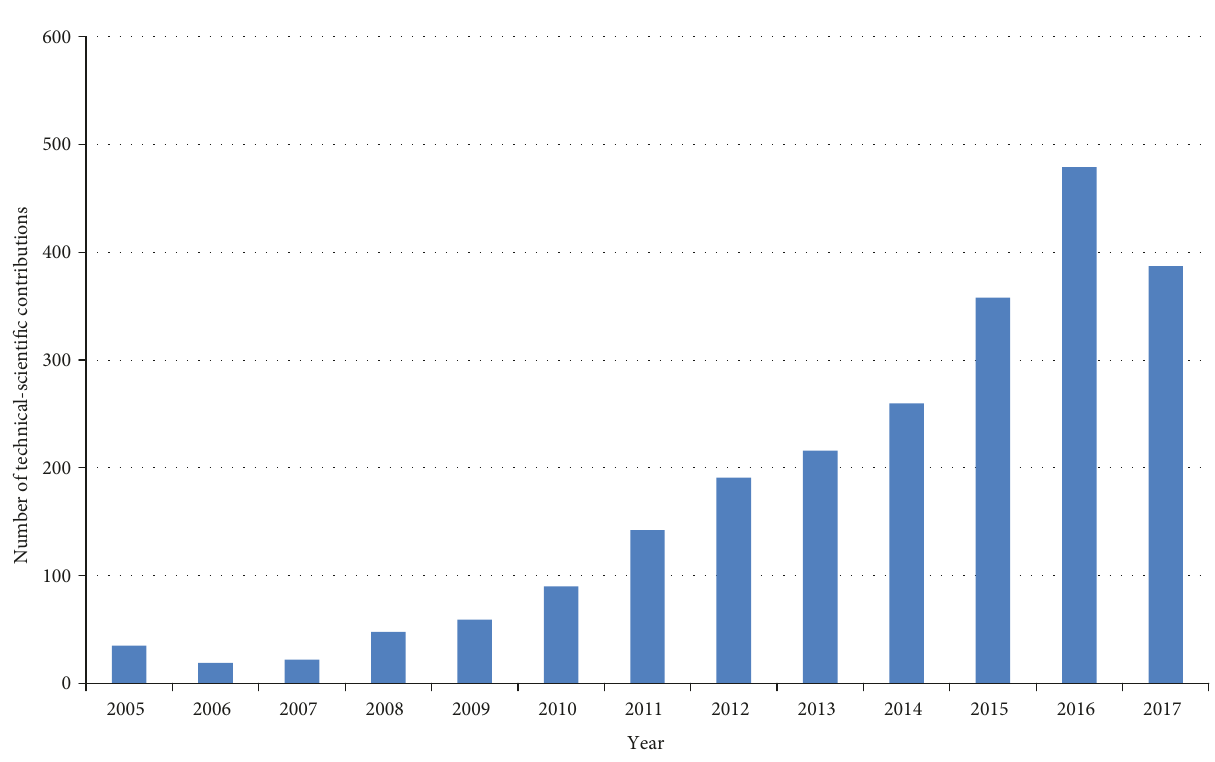
Figure 11: Distribution of technical-scienti fi c contributions related to CubeSats between 2005 and 2017, totaling 2306 documents (source: Scopus).